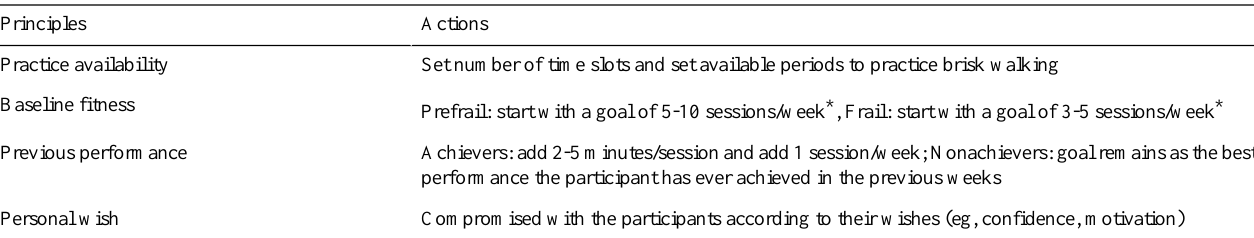
Table 3. Description of the tailored strategies as per personalized goals in the mHealth intervention.